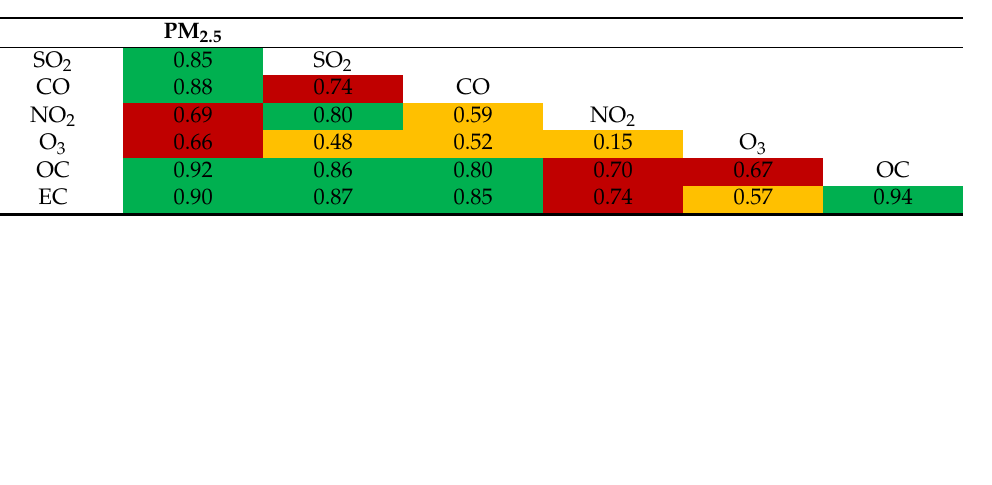
Table 1. Correlation value (R) between PM 2.5 , SO 2 , CO, NO 2 , O 3 , OC, and EC. Data with a green background are R values greater than 0.8. The yellow background are R values less than 0.6. The crimson background are R values between 0.6 and